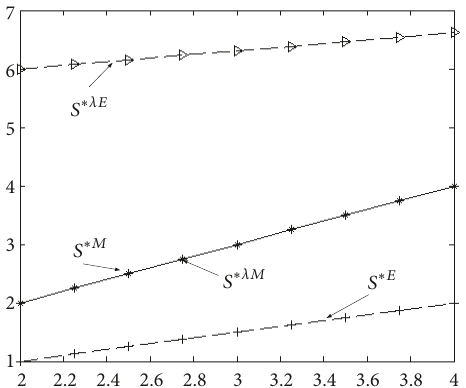
Figure 5: Change rule of manufacturer’s profit as 𝜌 changes.